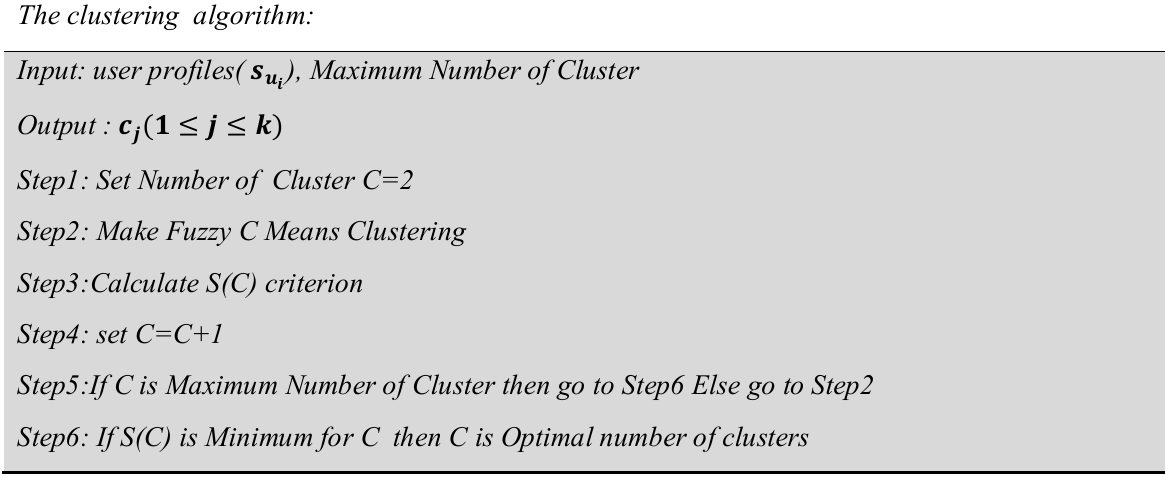
Fig. 2. FCM clustering algorithm with S(C)